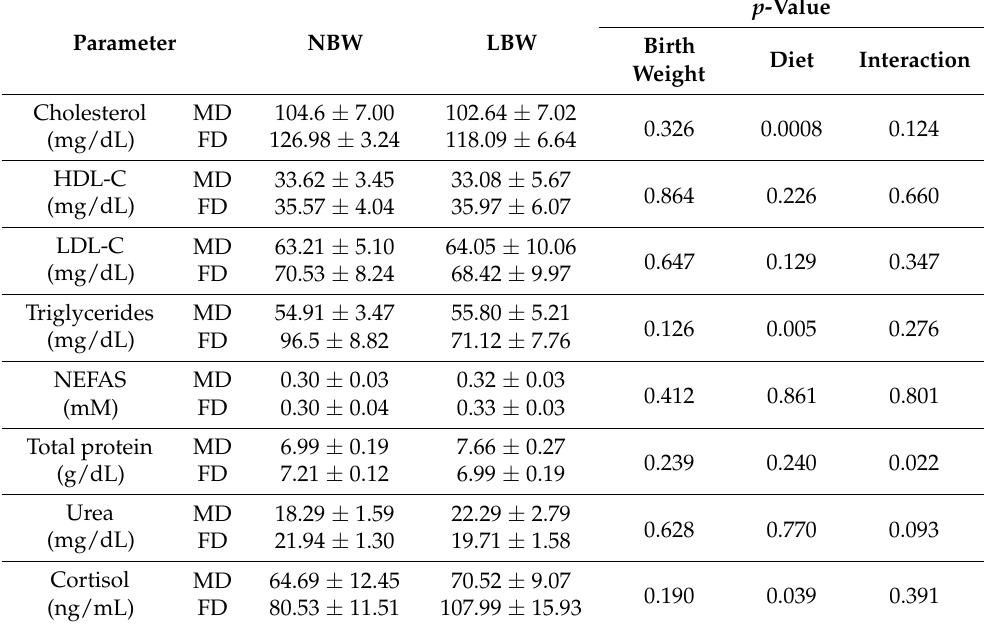
Table 1. Mean ( ± S.E.M.) and p values for plasma concentrations of metabolic parameters on day 385 of age in female and male pigs born with normal birth weight (NBW) or low birth weight (LBW) that were fed a maintenance diet (MD) or fattening diet (FD).